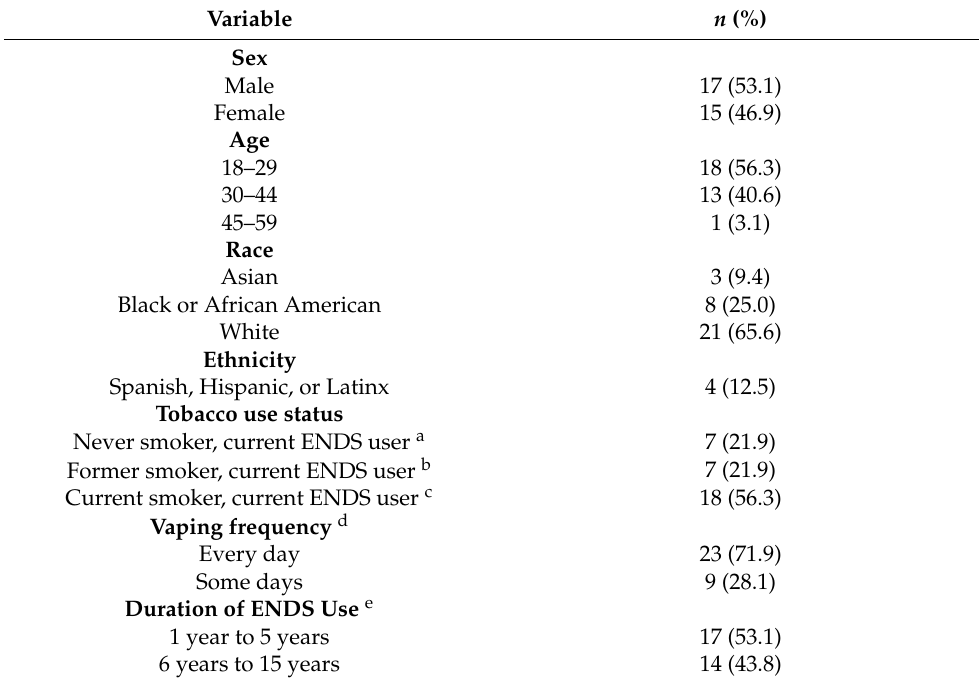
Table 1. Characteristics of Focus Groups Participants.